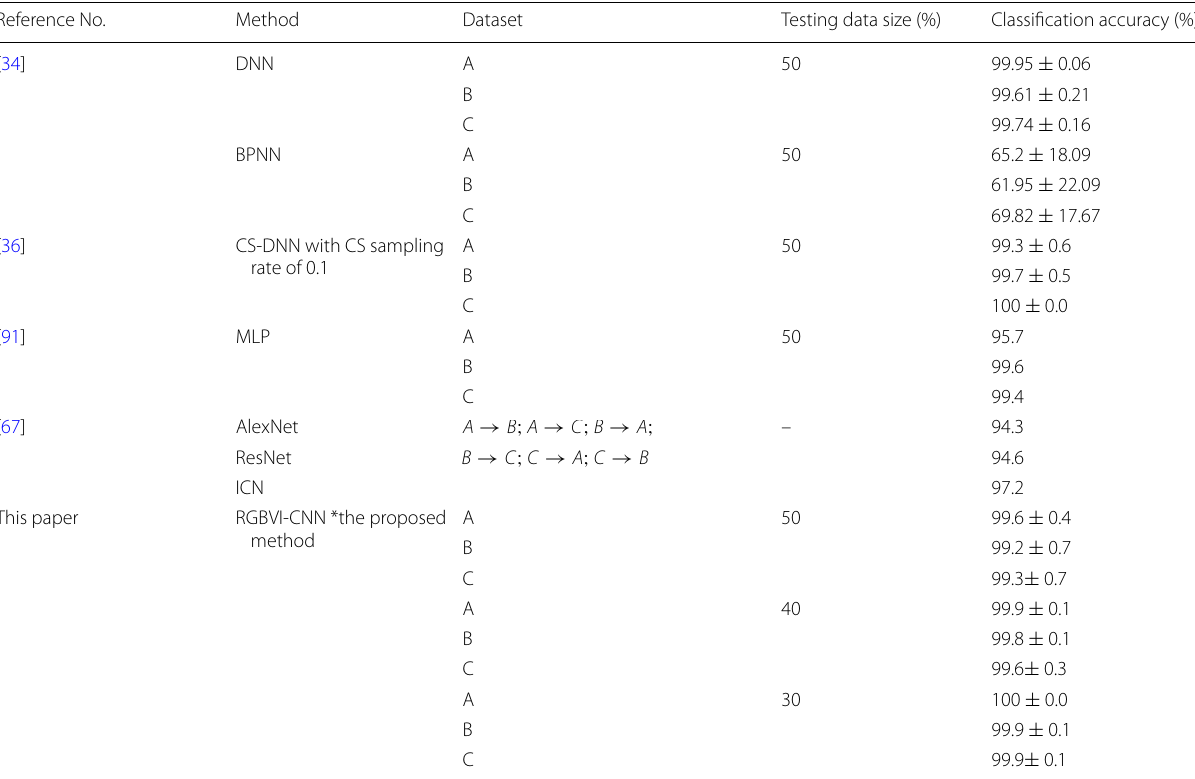
Table 7 A comparison with the classification results from the literature on bearing datasets A, B, and C datasets Reference